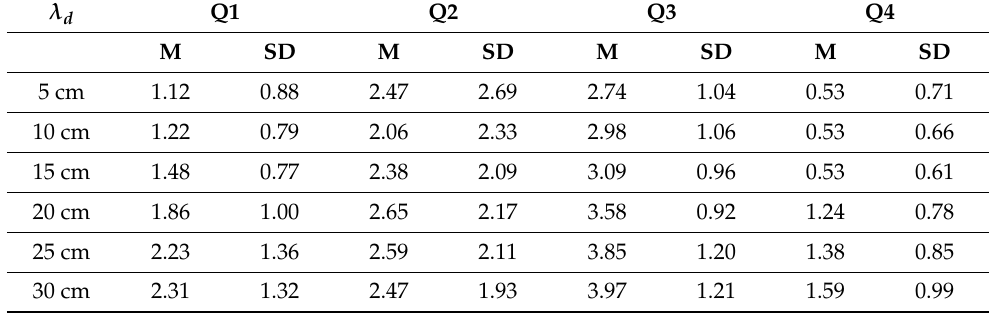
Table 3. Analysis of Q1, Q2, Q3, and Q4 for different threshold values.